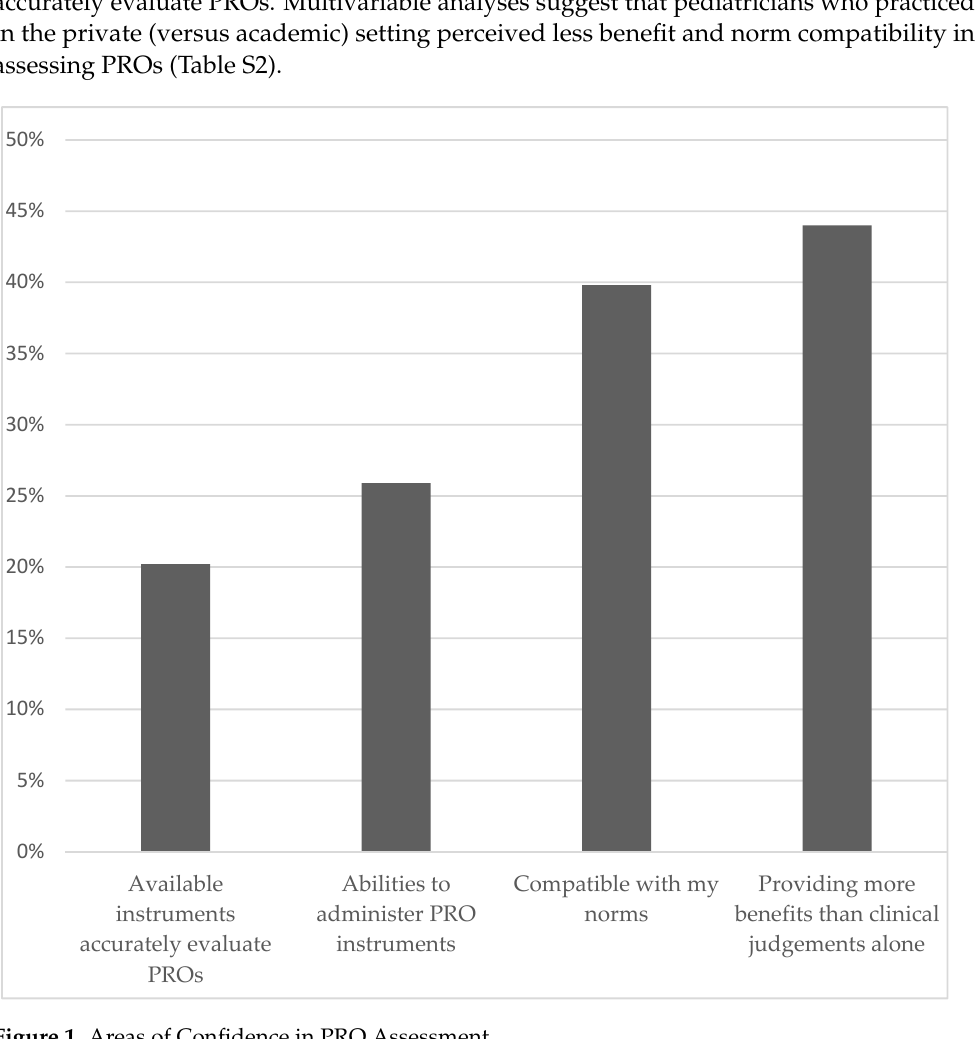
Figure 1. Areas of Confidence in PRO Assessment.